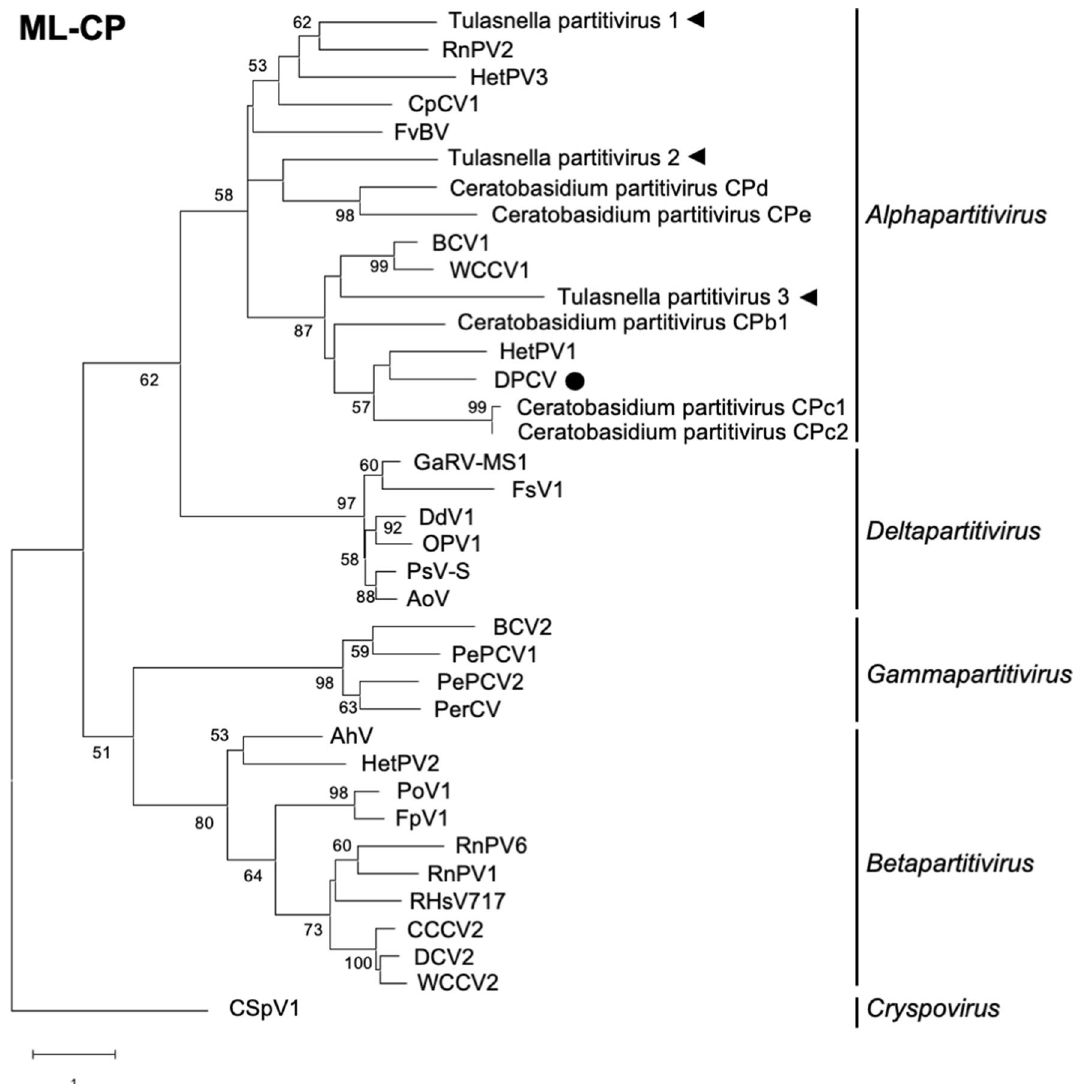
Figure 3. Phylogenetic tree based on the amino acid sequences of the CP of partitiviruses and constructed by the ML method. Bootstrap values > 50 are shown at the branch points. The evolutionary-distance scale is the number of substitutions per site. Tulasnella partitiviruses detected in this study are indicated by black triangles. The partitivirus detected in an Australian wild orchid (DPCV) is shown with a black